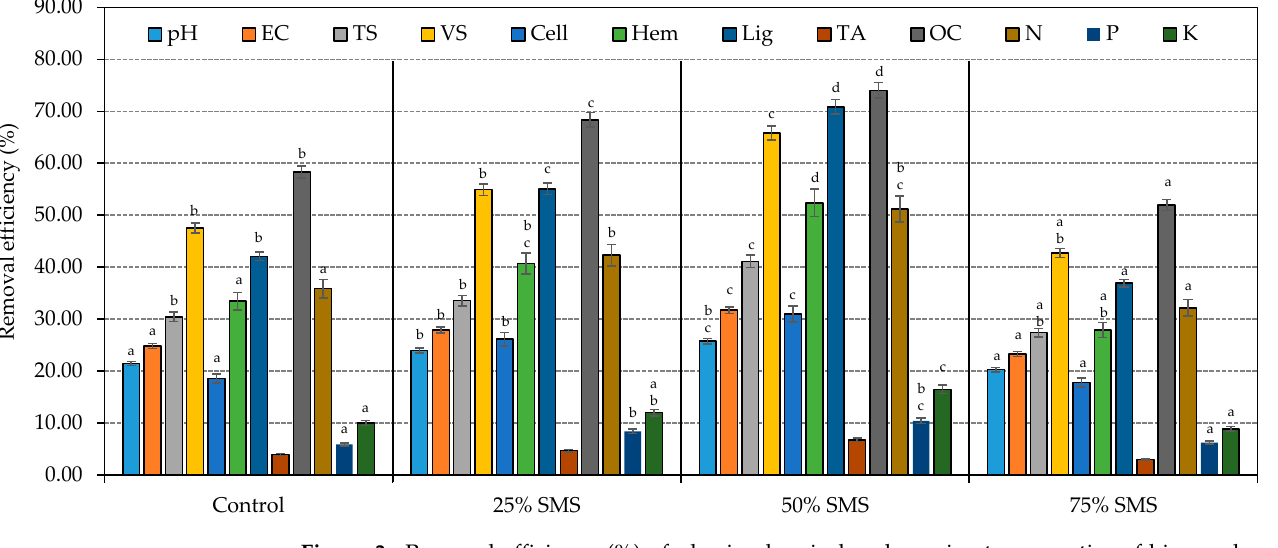
Figure 3. Removal efficiency (%) of physicochemical and proximate properties of biogas slurry prepared using different mixtures of SMS and CD (EC: electrical conductivity; TS: total solids; VS: volatile solids; Cell: cellulose; Hem: hemicellulose; Lig: lignin; TA: total ash; OC: organic carbon; N: nitrogen; P: phosphorus; K: potassium; the same letters (a–d) indicate no significant difference among treatment group values at p < 0.05).